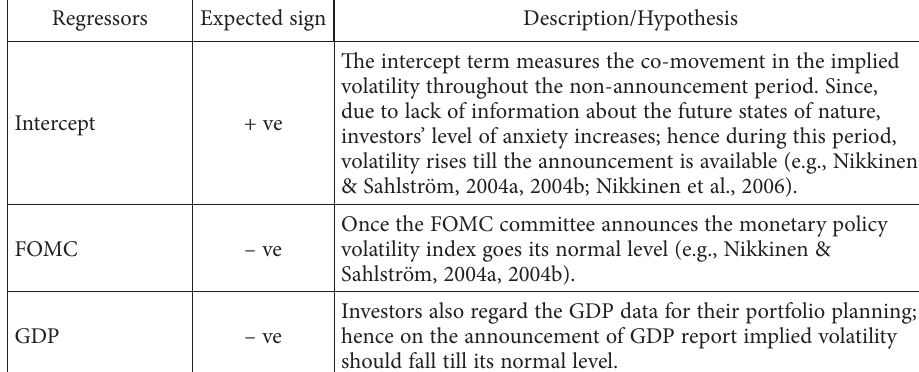
Table 1. The hypothesis of the model (source: authors’